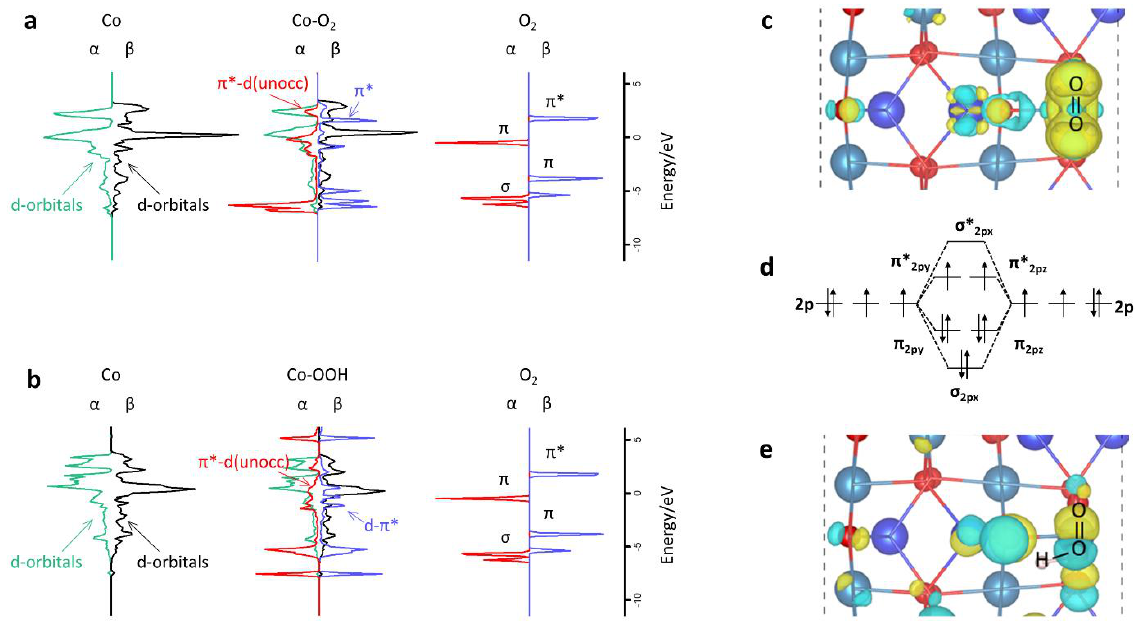
Figure 5. Electronic structure analysis. ( a ) Projected electronic density of states (PDOS) and schematic illustrations of 3D orbitals of Co on Co 3 O 4 (110) surface, 2p-orbitals of the O 2 gas molecule, and their interaction within Co 3 O 4 -O 2 configuration. ( b ) PDOS and schematic illustrations for Co 3 O 4 -OOH interaction configuration. As the O 2 and OOH adsorb on a Co top site, the PDOS displays this Co atom and O 2 /OOH.( c , e ) The charge density difference of O 2 and OOH adsorb on Co 3 O 4 (110) surface, respectively. ( d ) O 2 molecular orbitals.